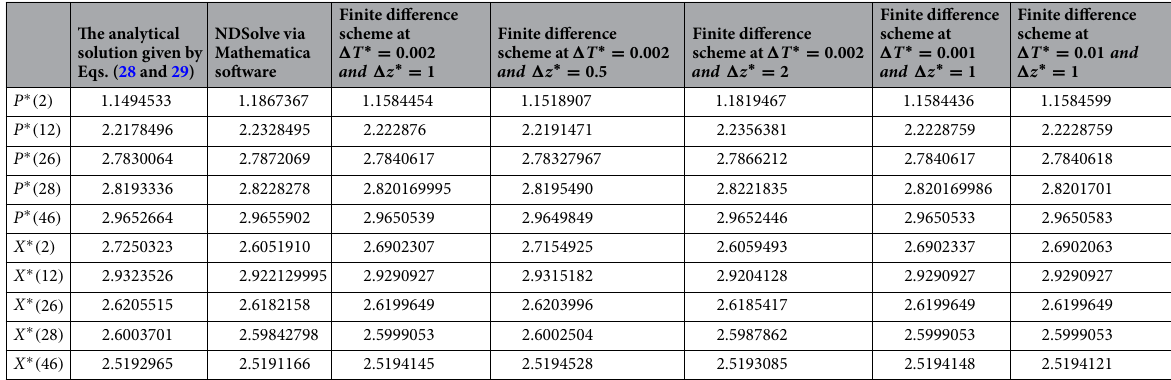
Table 1. A comparison between the steady-state solutions using the finite difference method, NDSolve via Mathematica, and the analytical